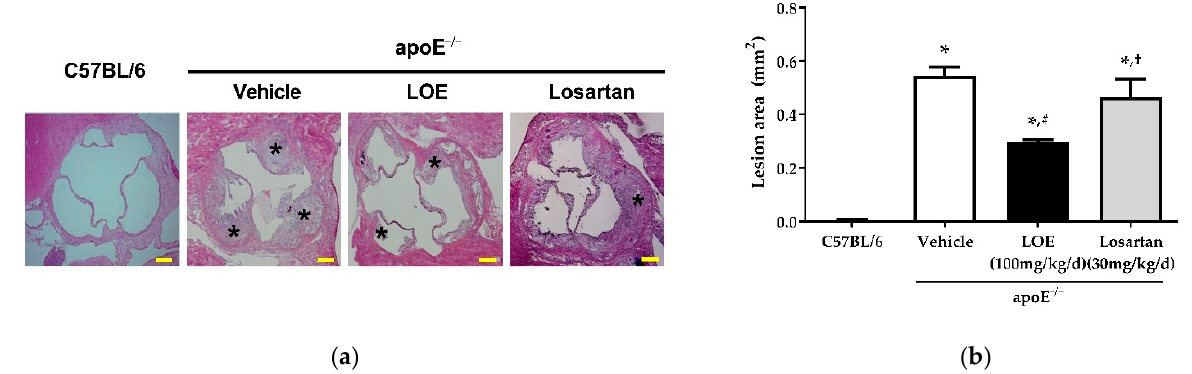
Figure 5. Effect of LOE and losartan treatments on the atherosclerotic plaque areas of aortic sections obtained from apoE − / − mice. LOE treatment significantly reduced the extent of aortic plaque, whereas losartan failed to reduce the area of atherosclerotic lesion in western diet-fed apoE − / − mice. The atherosclerotic plaque area (mm 2 ) was measured as the area between the internal elastic lamina and the lumen and quantified by ImageJ after H&E staining. ( a ) H&E staining. Asterisk (*) indicates atherosclerotic plaque. ( b ) Corresponding cumulative data. The scale bar represents 200 µ m. The results are expressed as mean ± SEM ( n = 4–6). * p < 0.05 versus the C57BL/6 group, # p < 0.05 versus the apoE − / − vehicle group and † p < 0.05 versus the apoE − / − LOE